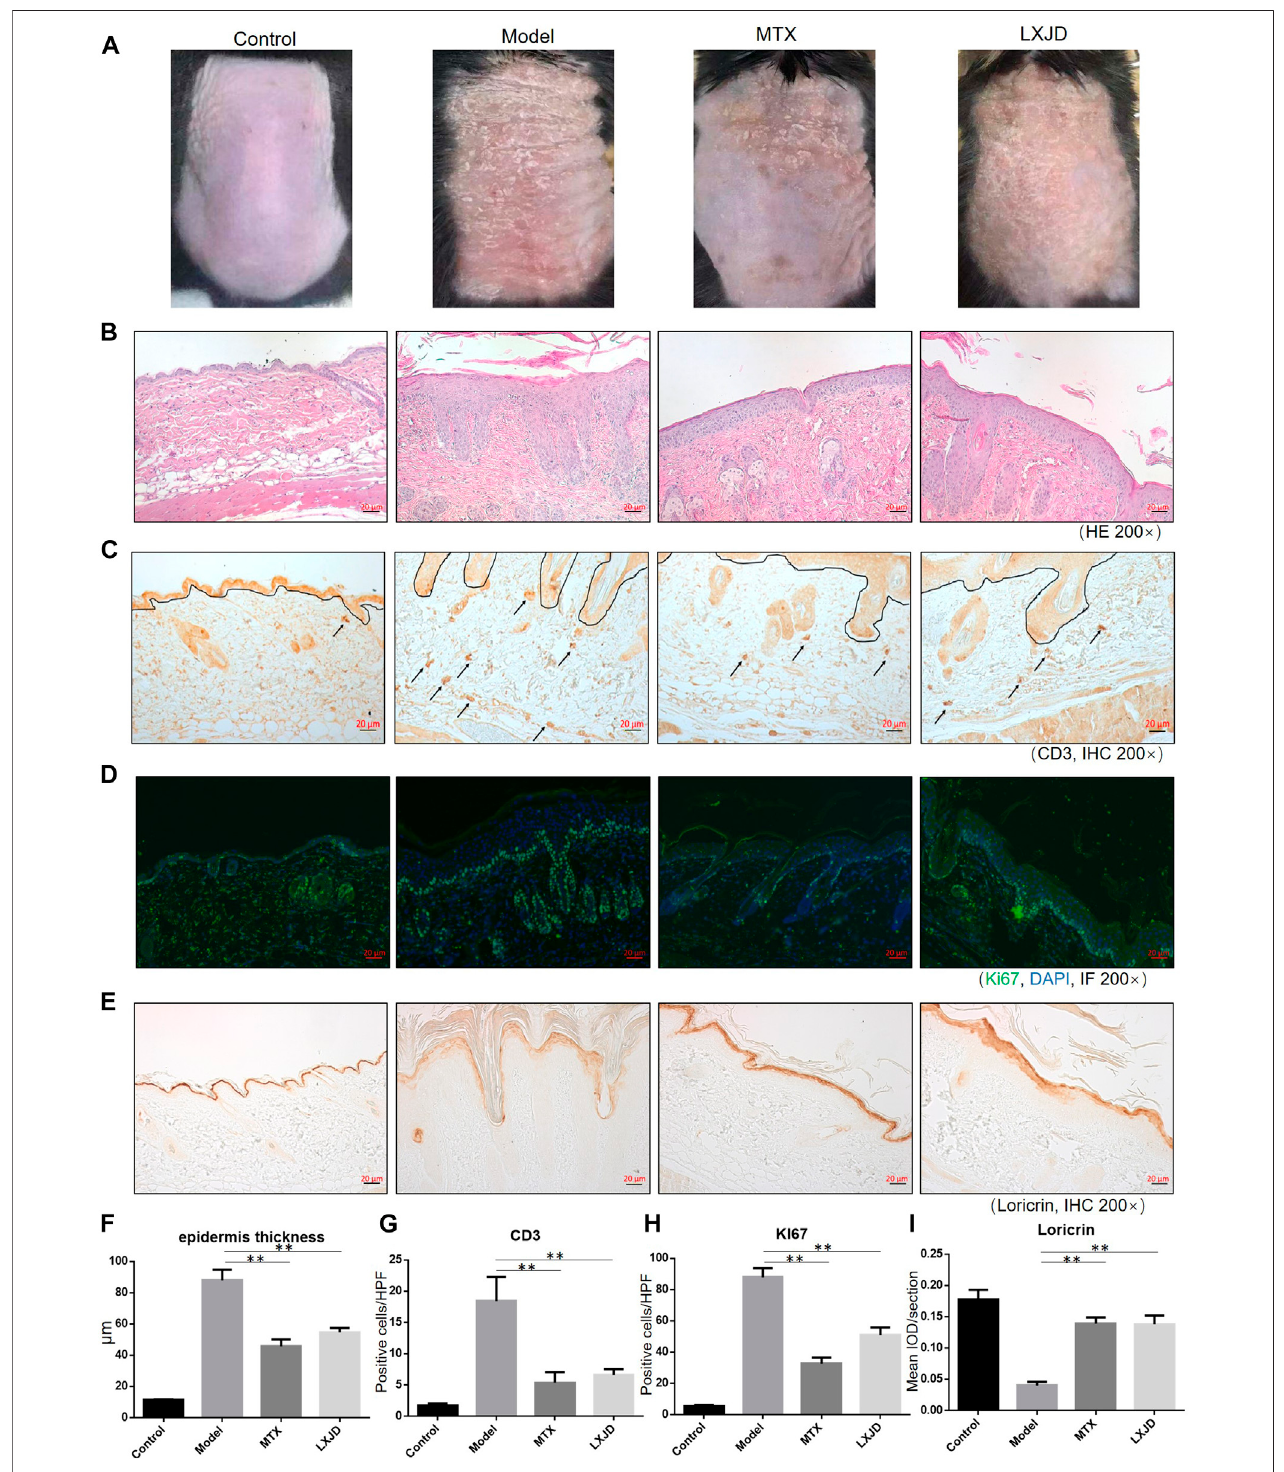
FIGURE 5 | C57 BL/6 mice were treated daily with IMQ cream on the shaved back skin to induced psoriasis-like dermatitis, while the control group (CTRL) was treated with matrix. The IMQ-treated mice were administered saline (model) [methotrexate (MTX) serves as a positive control] or LXJD formula for a total of 7 days. (A) Phenotypicpresentation oftheback skinon day7after IMQtreatment. (B) Histologicalanalyses ofmouseback skinbyH&Estaining. (C) Immunohistochemicalstaining ofCD3+cellsinskin lesions.Mouseback skin wasstainedforKi67 (D) andloricrin (E) . (F – I) Quanti fi cationanalysisforepidermisthickness, CD3+and Ki-67+,and loricrin was performed. Data are shown as mean ± SD. n (cid:2) 5 mice. * p < 0.05 and ** p < 0.01 vs. model group.